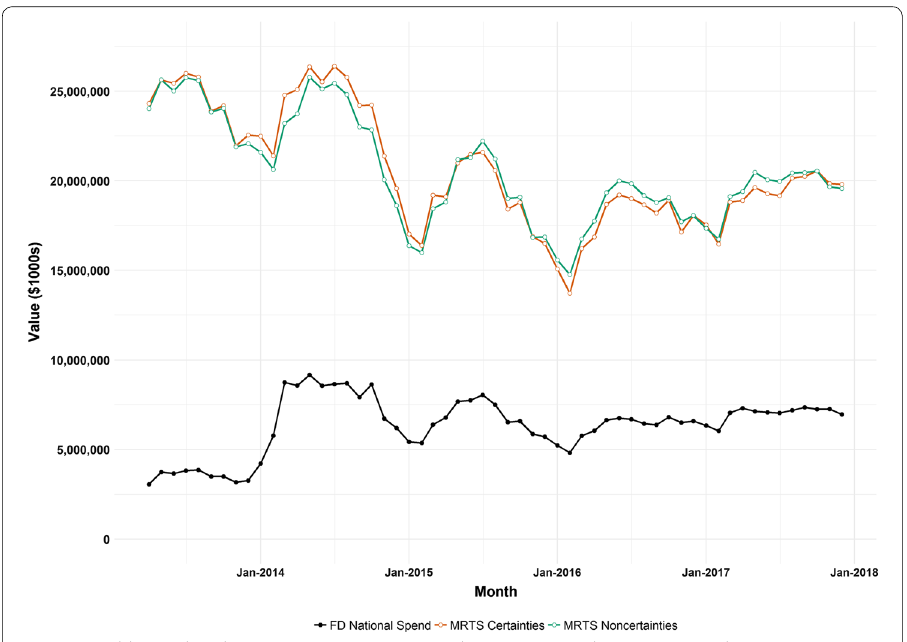
Fig. 2 Monthly Retail Trade Survey (MRTS) certainty and noncertainty sales estimates and First Data (FD) national spend over time for NAICS 447 (gasoline